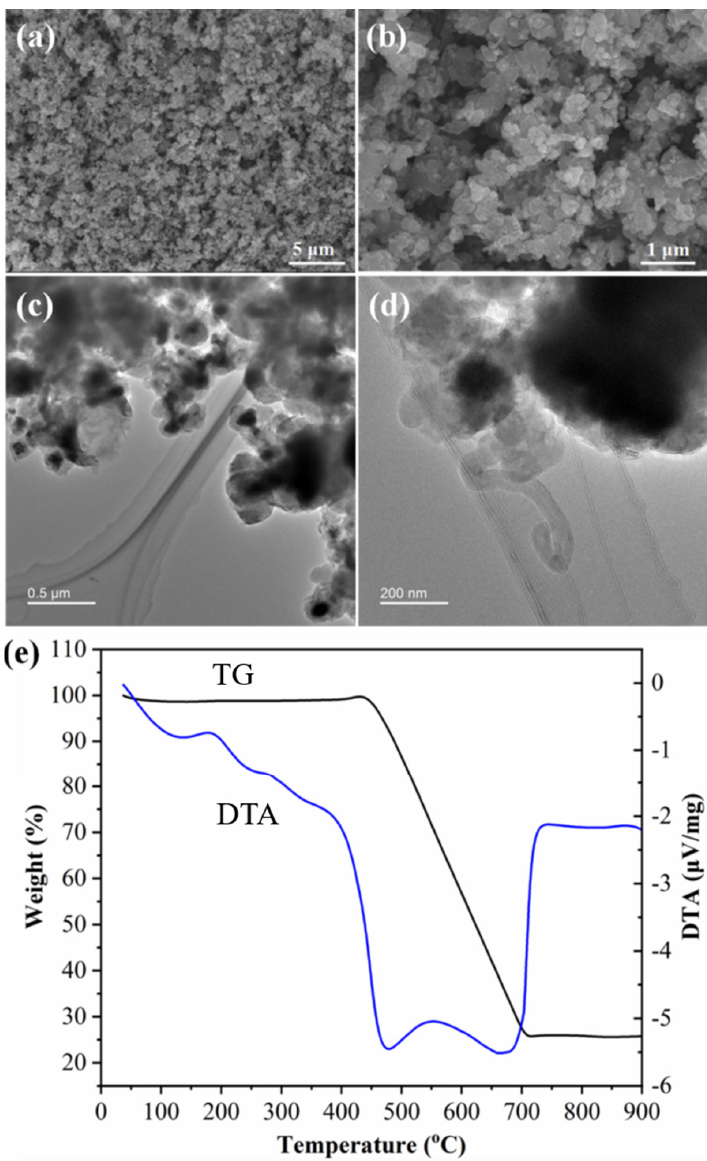
Figure 6. SEM ( a , b ) and TEM ( c , d ) images of deposited carbon with the NiCo catalyst; temperature– programmed oxidation and differential thermal analysis(DTA, exothermal in the negative direction) plots of carbon/NiCo catalyst ( e ).